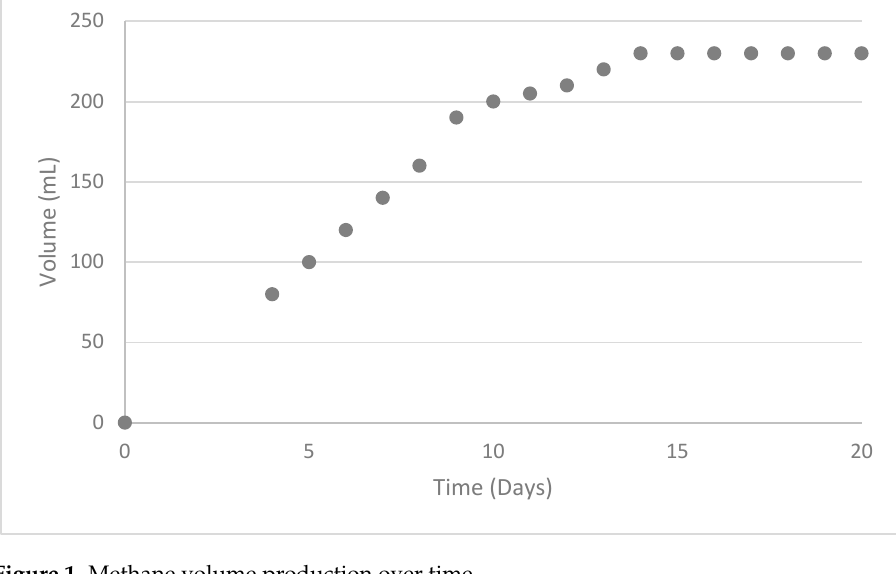
Figure 1. Methane volume production over time.